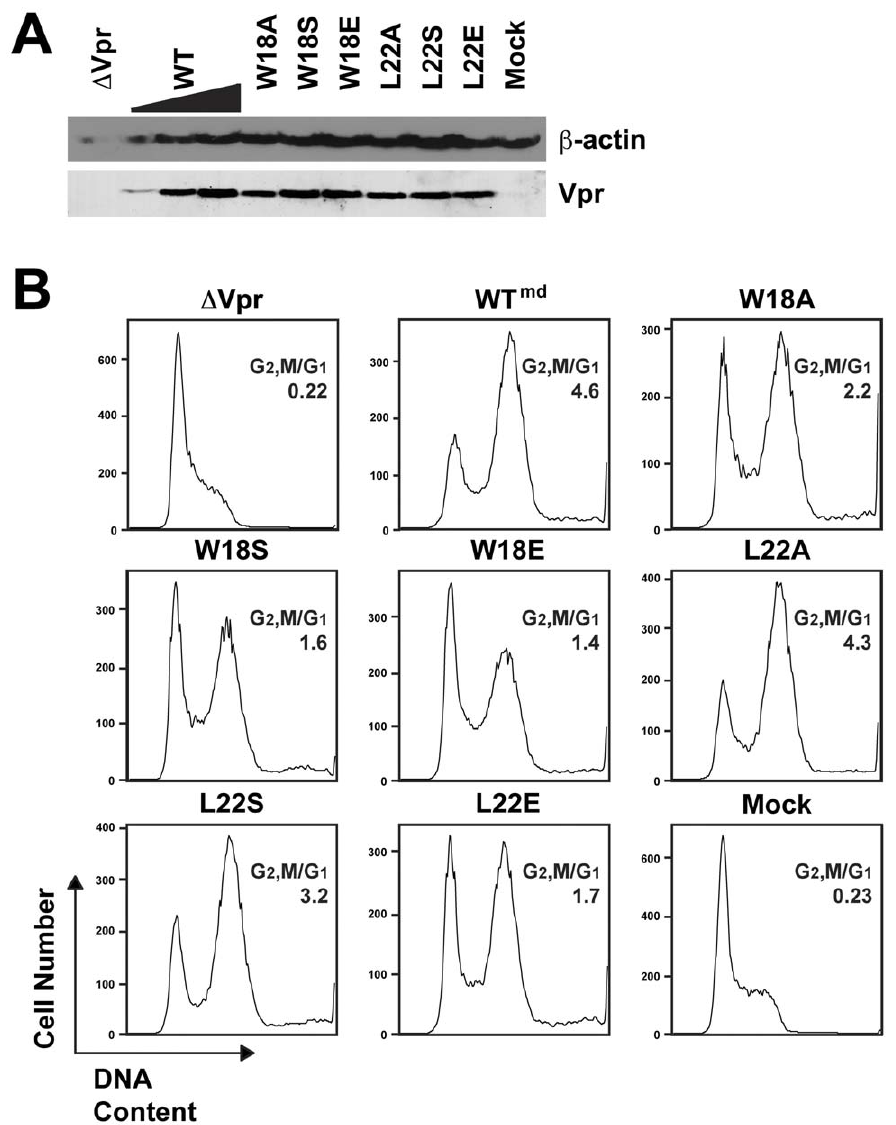
Figure 3. Hydrophobic residues on Vpr helix-1 are important for virion-delivered Vpr cell cycle arrest. WT or mutant Vpr proteins (denoted by the single letter amino acid changes) were delivered (Vpr v ) into Jurkat cells. Virions containing WT Vpr were titrated (md, medium) so that a matched Vpr protein control could be compared to the mutants. ( A ) Western blot of the Jurkat cells for WT and mutant virion-delivered Vpr (bottom). b -actin is shown as a protein loading control (top). ( B ) Histograms of cell cycle analysis at 41 hr post-infection show DNA content of PI- stained cells by flow cytometry. All samples represent 10,000 cellular events. G1 and G2/M populations were modeled using the Watson Pragmatic cell cycle model, and the G2,M/G1 ratio in each infection is shown. The data are representative of three